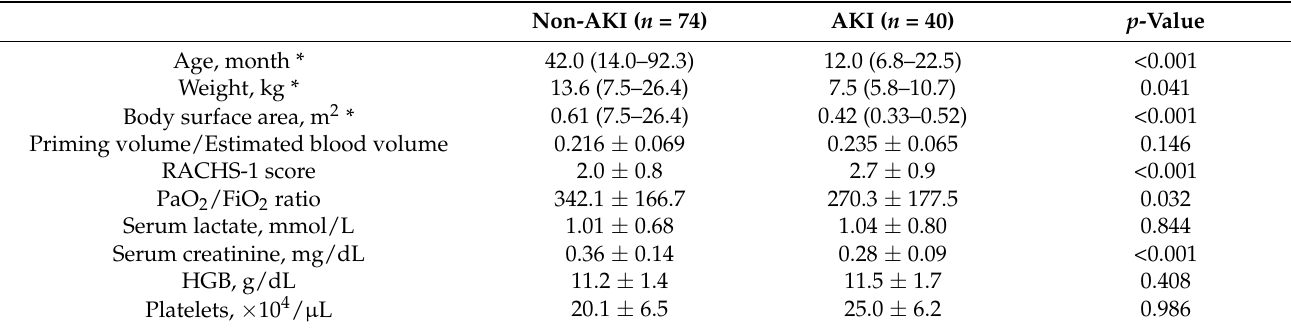
Table 2. Comparison of the preoperative clinical